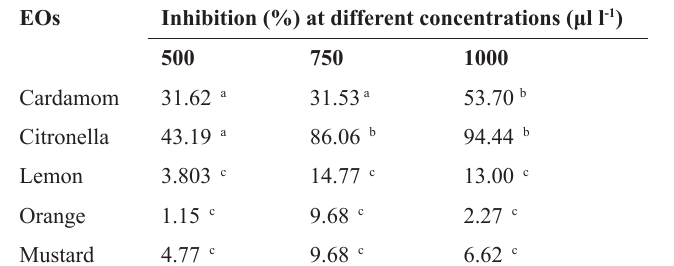
Table 1: Percentage mycelial inhibition of Colletotrichum sp. isolated from papaya on PDA Petri plates enriched with different essential oils at the time when control reached its maximum growth (90 mm) at 48 h (day 2) after inoculation.